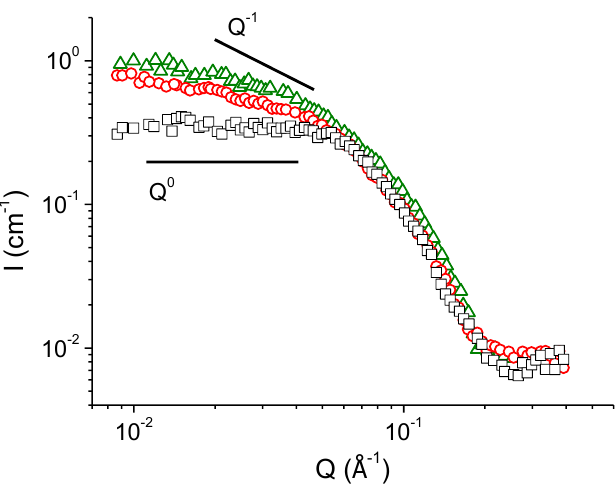
Figure 2. SANS curves of 94 mM solutions of potassium oleate in the solvent containing 37 vol% D 2 O and 73 vol% H 2 O at pH 11 in the presence of different concentrations of KCl: 67 mM (squares), 110 mM (circles) and 160 mM (triangles). Solid lines show slopes of the Q 0 and Q −1 dependences.